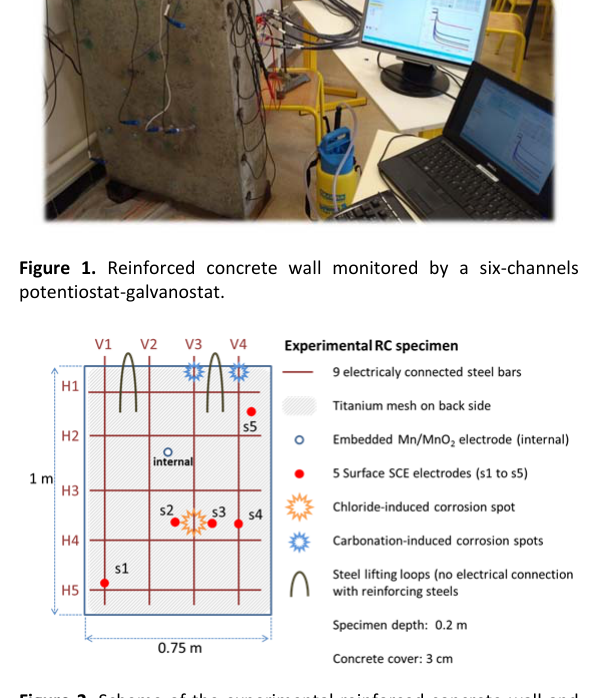
Figure 2. Scheme of the experimental reinforced concrete wall and location of the different references